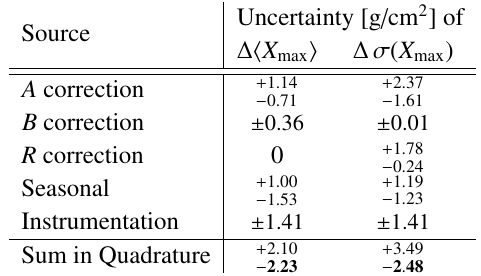
Table 1: Systematic uncertainties on the di ↵ erence in the X max means,  , and widths,   ( X max ), of the on- and o ↵ - h i plane X max